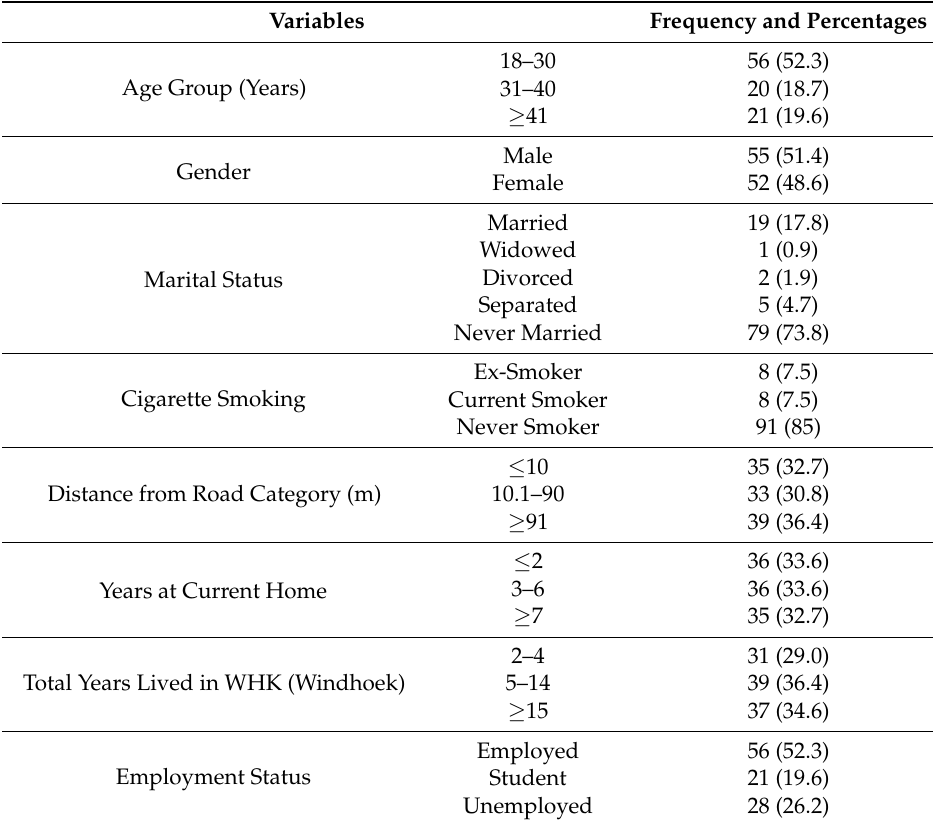
Table 1. Participants’ demographic